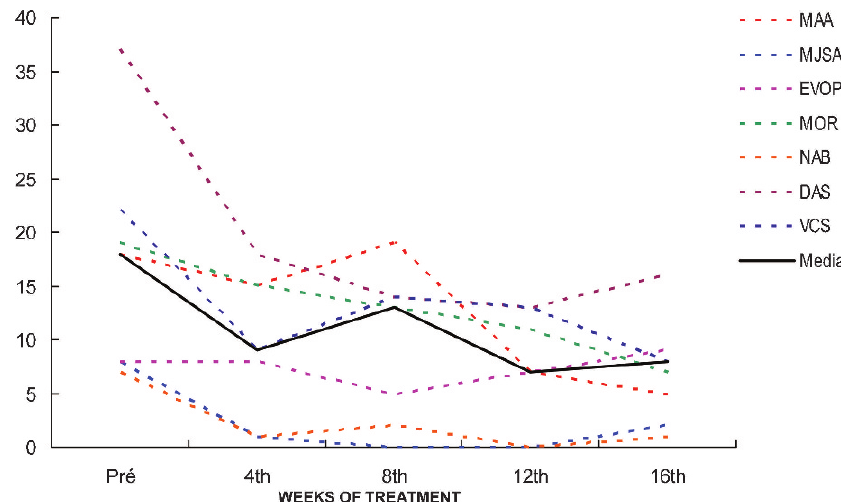
Figure 3 - Depression scores of volunteers as evaluated by BDI questionary during sessions with therapeutic massage.